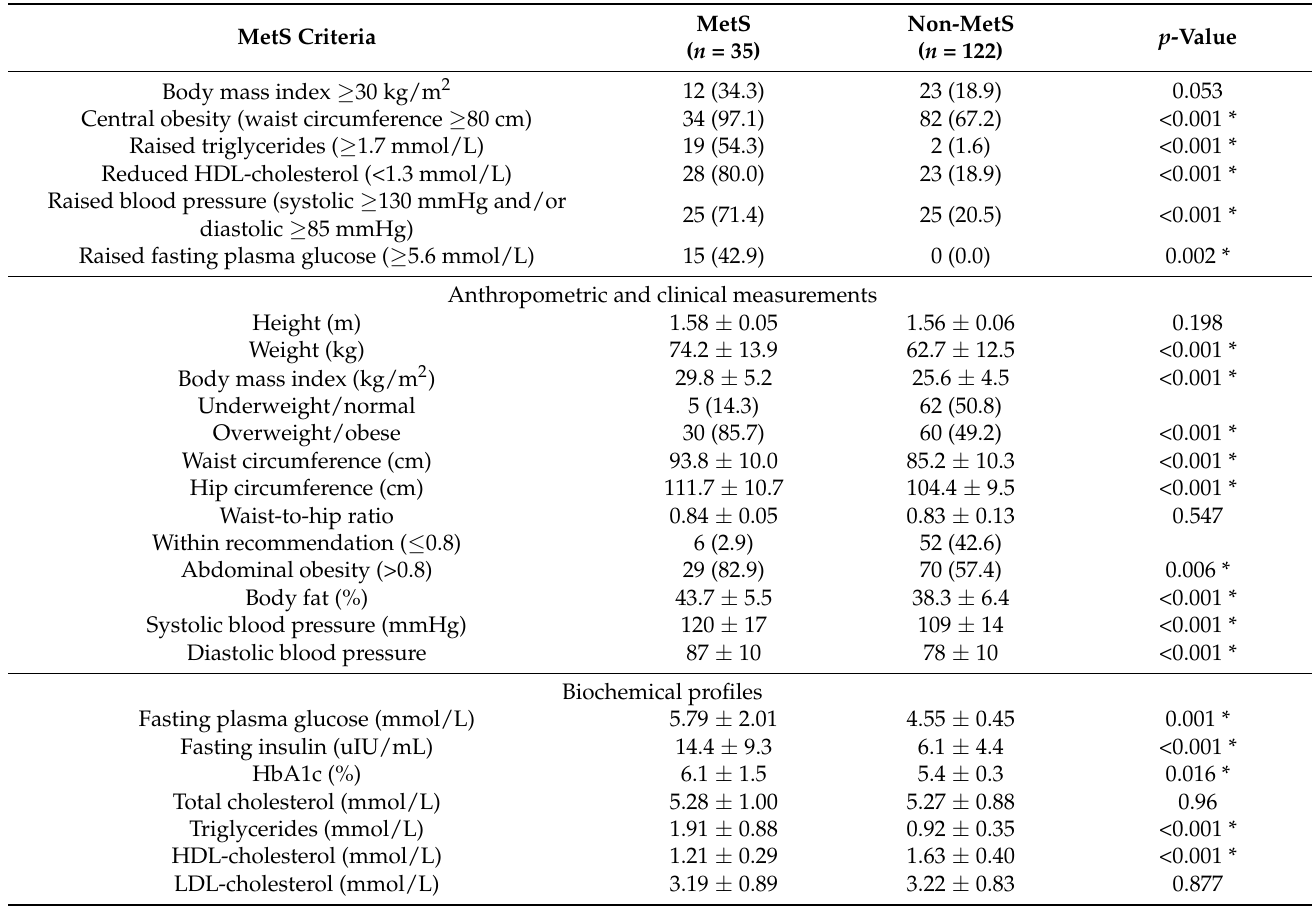
Table 1. Metabolic syndrome and cardiometabolic risk factors in participants ( n = 157).